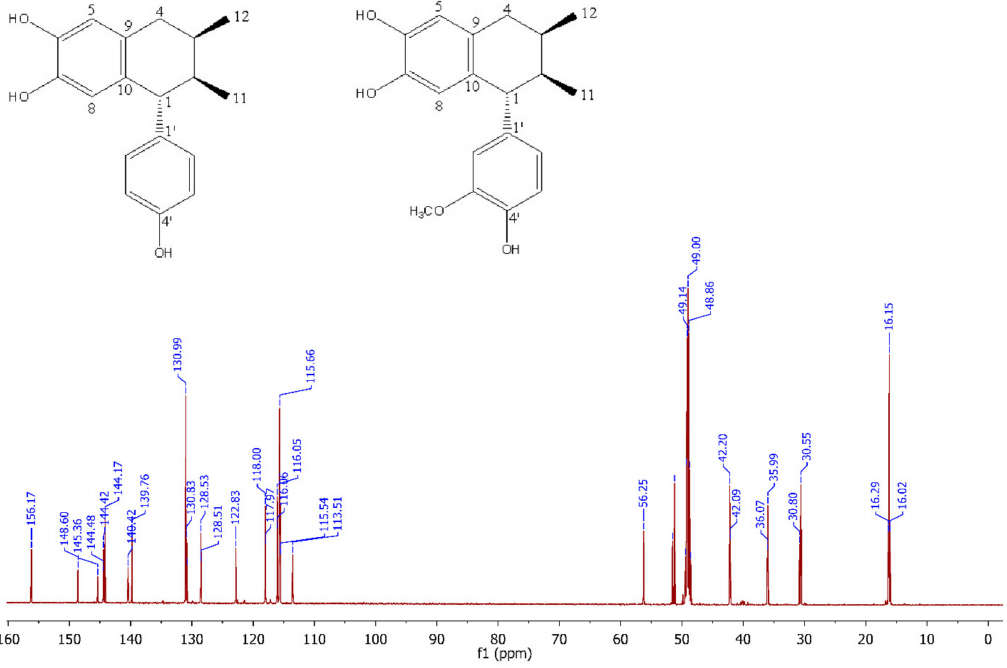
Figure A2. 13C NMR (CD3OD, 150 MHz) of 3 (cid:48) -demethoxy-6-O-demethylisoguaiacin ( 1 ) and 24 norisoguaiacin ( 2 ).